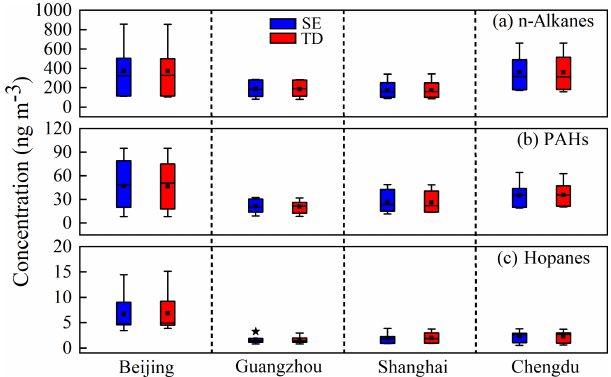
Figure 7. Box plots of n-alkanes (a) , PAHs (b) and hopanes (c) concentrations (ngm − 3 ) in Beijing, Guangzhou, Shanghai and Chengdu during winter 2013. The boxes represent the 25th per- centile (lower edge), median (solid line), mean (cube mark) and 75th percentile (higher edge). The whiskers represent the minimum and maximum. The star mark represented one outlier for the sam- ples collected in